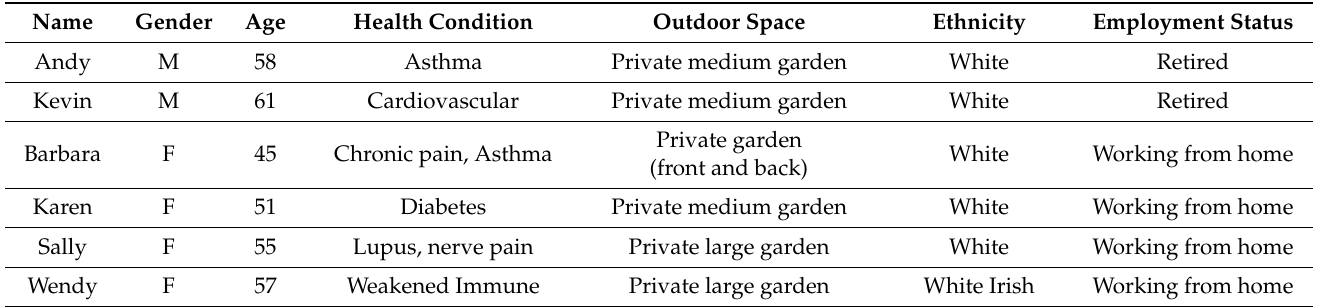
Table 1. Overview of the 17 participants quoted in the text, including pseudonyms, gender, age, health condition, outdoor space, ethnicity, and employment